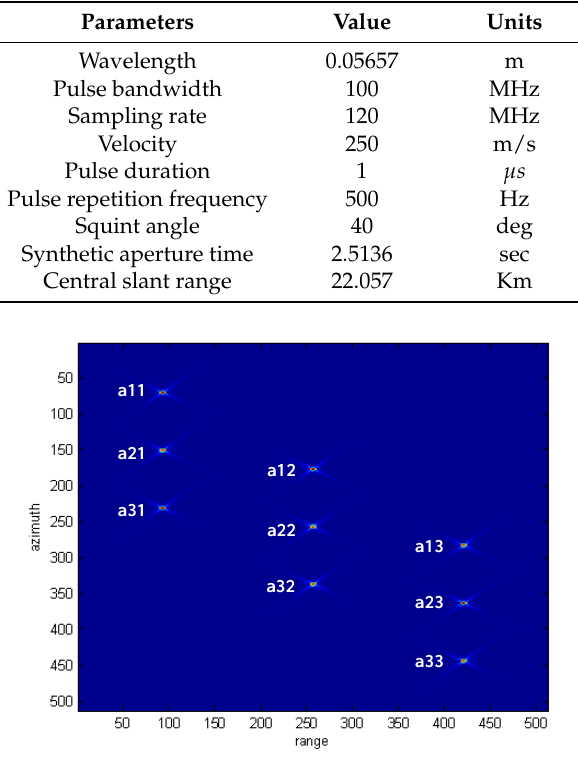
Figure 8. The original squint SAR Image.